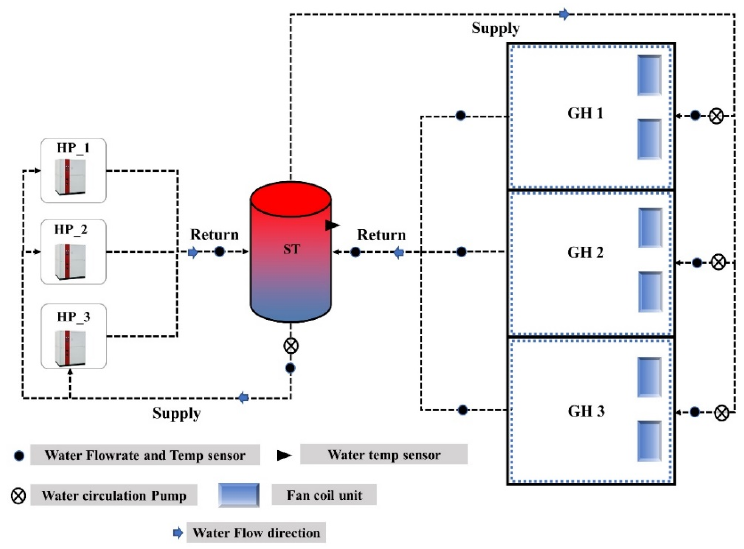
Figure 4. Diagram of AWHP system.